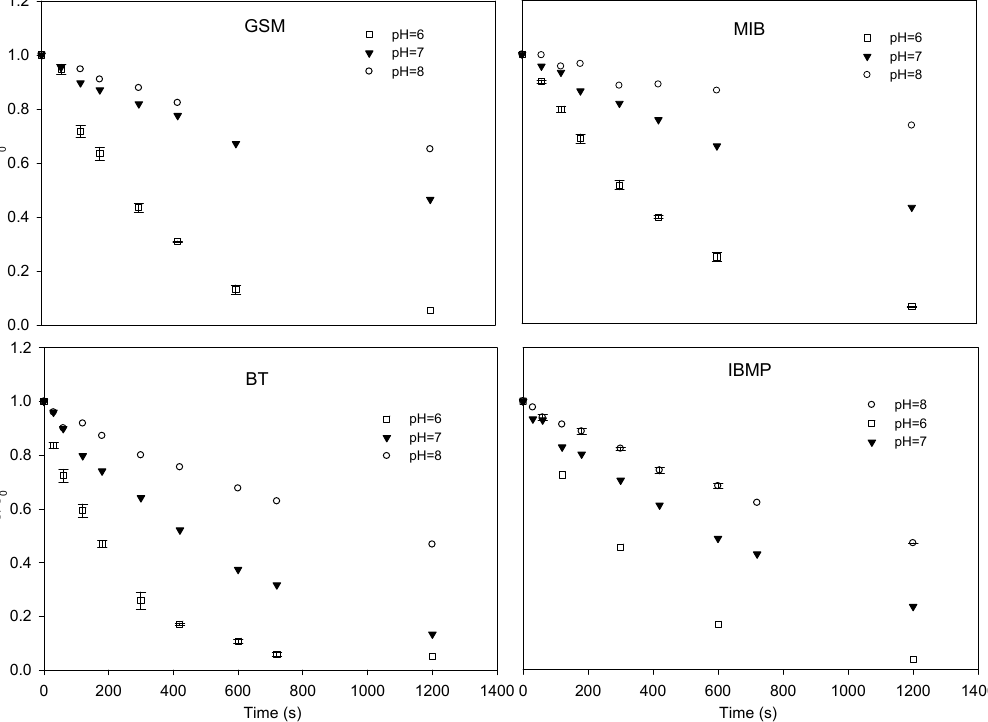
Figure 2. Time-dependent degradation of GSM, MIB, BT, and IBMP in pure water through the UV/chlorine process at different pH levels. Conditions: pH = 6, 7, and 8; chlorine concentration = 50 μ M; GSM and MIB concentration = 400 nM; BT and IBMP concentration = 1 μ M; NB concentration = T&O compound concentration; Incident photon flux = 0.69 μ Einstein L − 1 s − 1 .